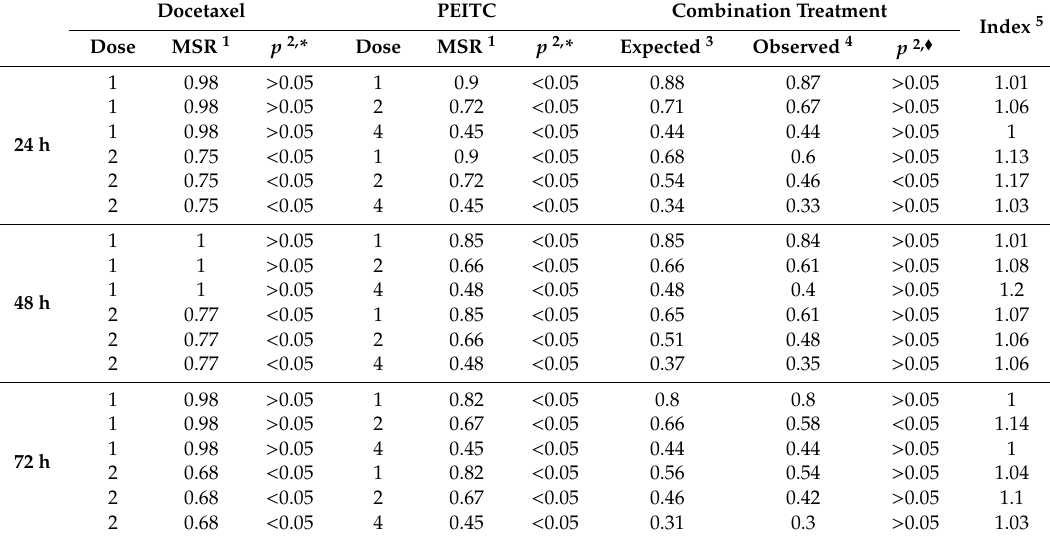
Table A8. Analysis of synergy between PEITC and DOCE calculated by survival rate for DU 145